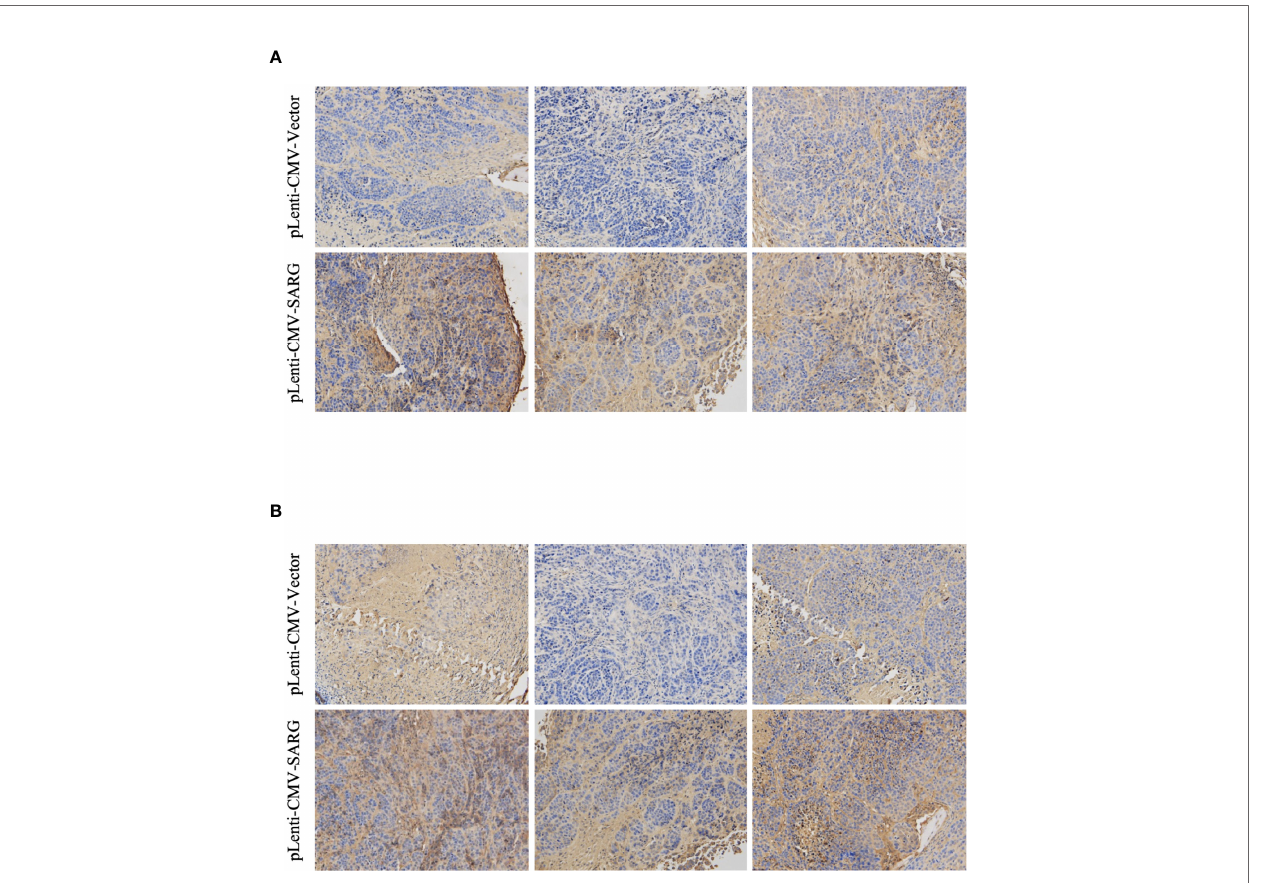
FIGURE 8 | Representative immunohistochemistry assay images of VEGF-C (A) and VEGFR3 (B) staining in TPC-1 xenografts tissue transfected with vector control plasmids or SARG overexpressing plasmids. VEGF-C, vascular endothelial growth factor C; VEGFR-3, vascular endothelial growth factor receptor 3; SARG, speci fi cally androgen-regulated